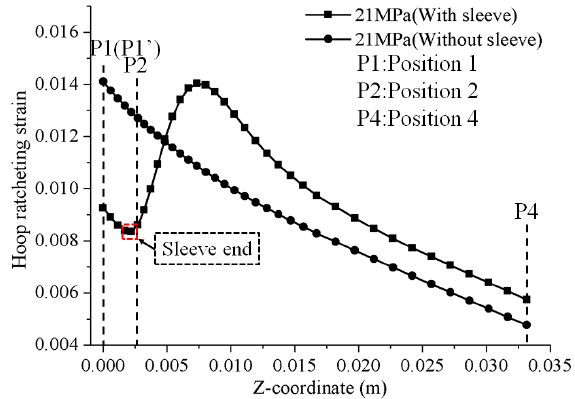
Figure 6. The effect of the sleeve on the hoop ratcheting strain after 45 cycles.